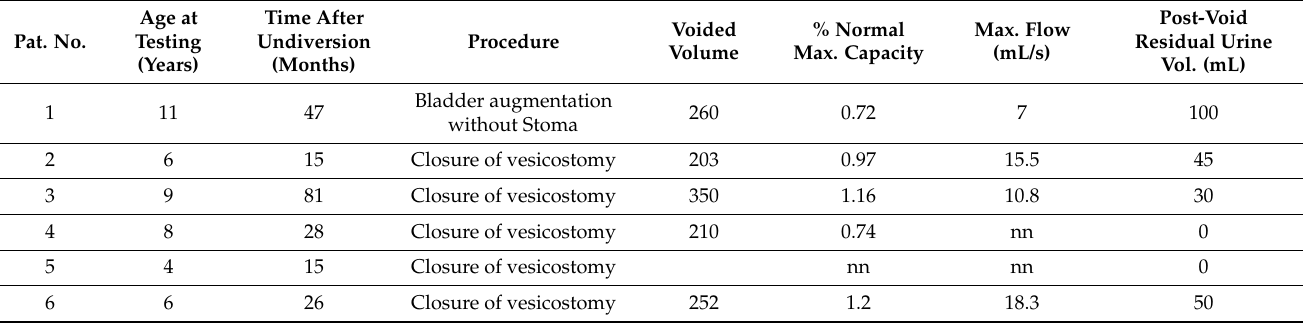
Table 7. Free flow/voiding results after